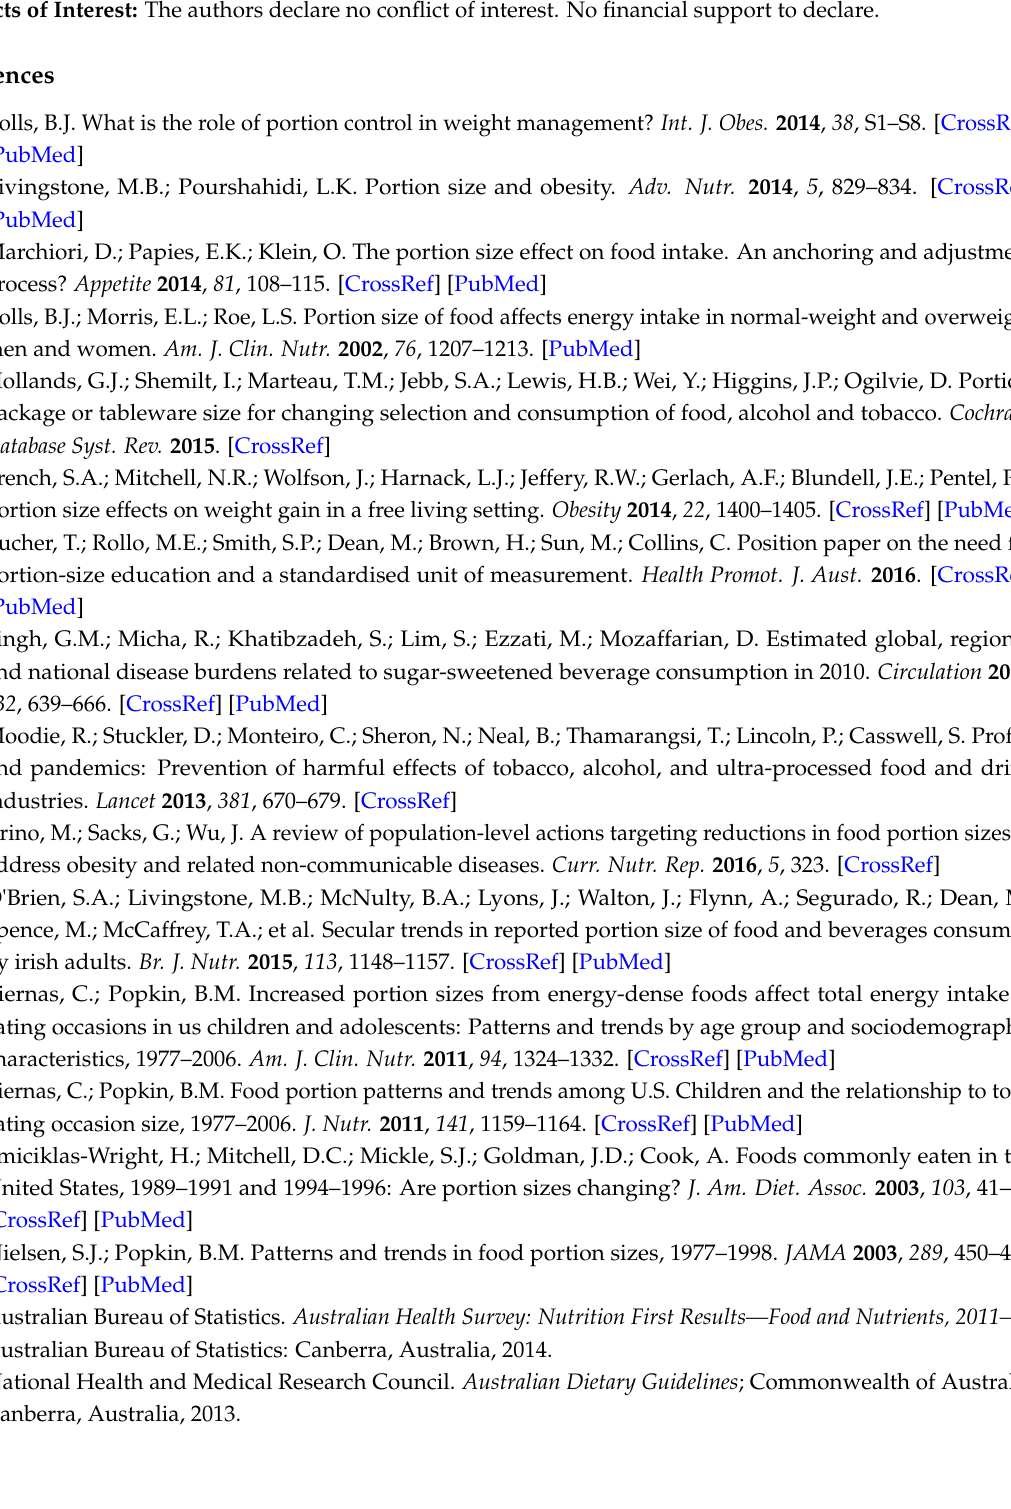
Table S1: Discretionary food categories included in this analysis, Table S2: Comparison of typical portion sizes (in kJ) of discretionary foods in 1995 and 2011–2012, Table S3: Percentage difference in typical portion size (g) between 1995 and 2011–2012 by age and socioeconomic status